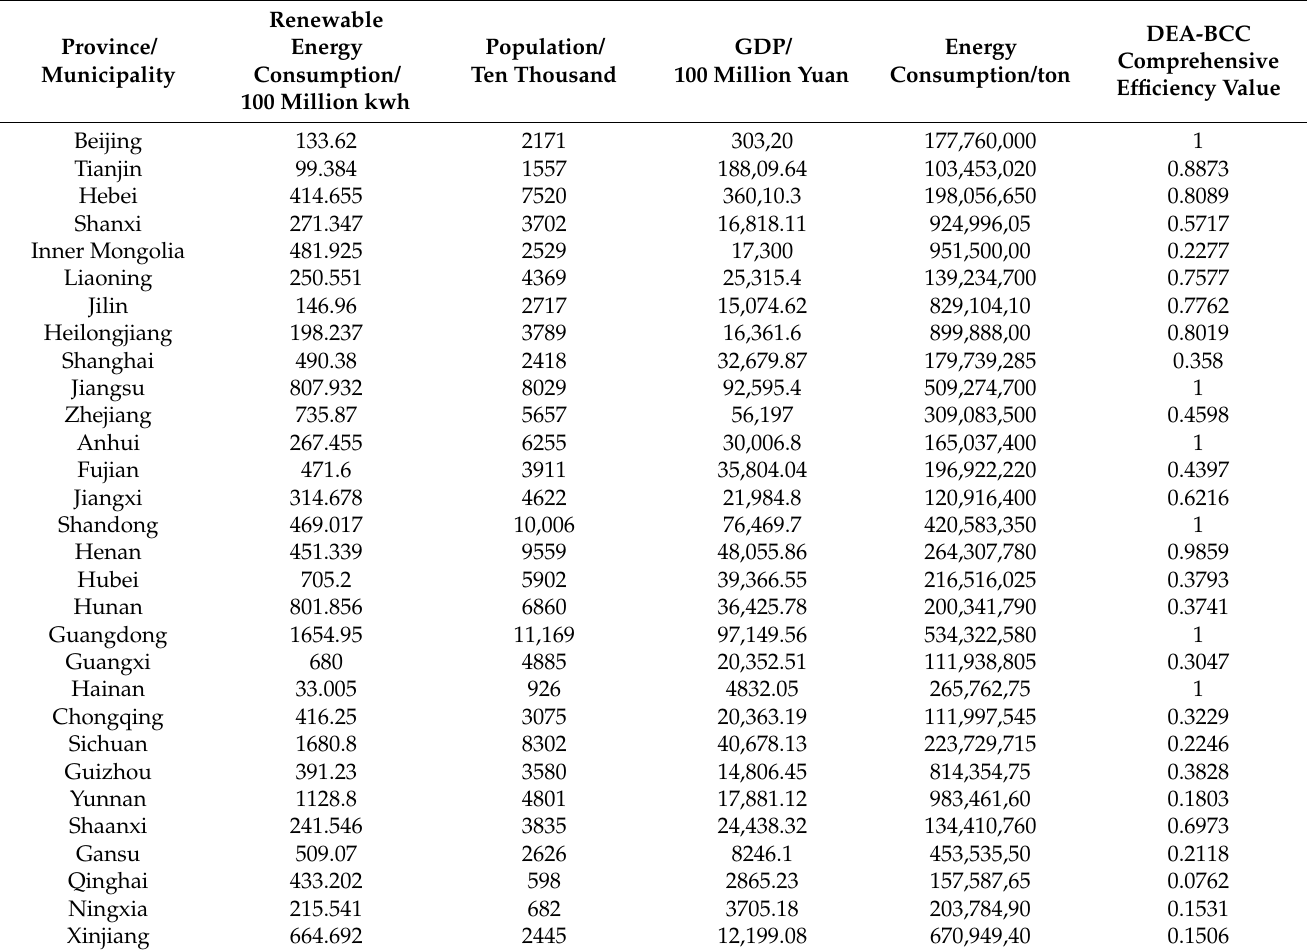
Table 4. Efficiency of Quota Distribution by Provinces in